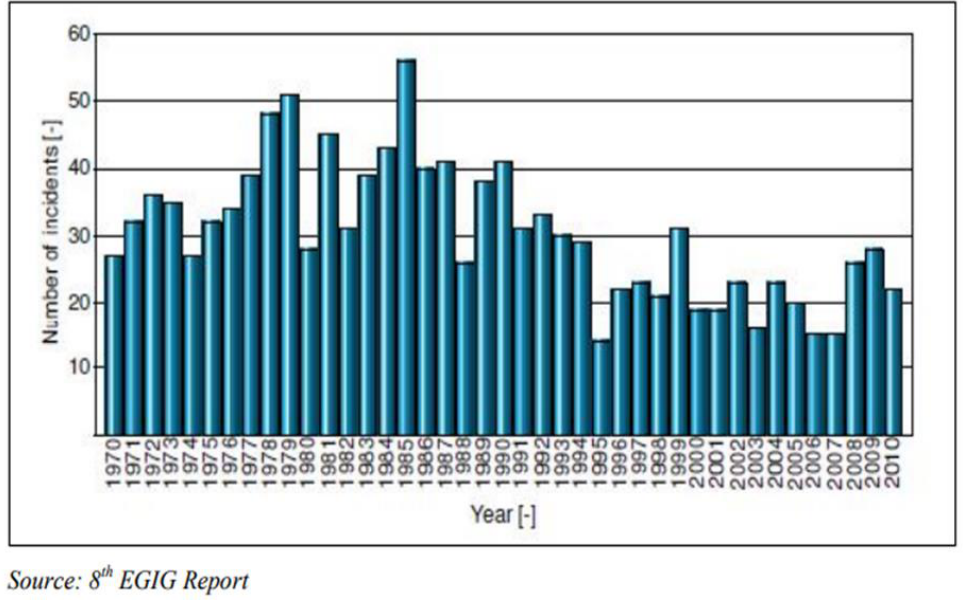
Figure 2. Natural gas pipeline failure incidents (1970 –